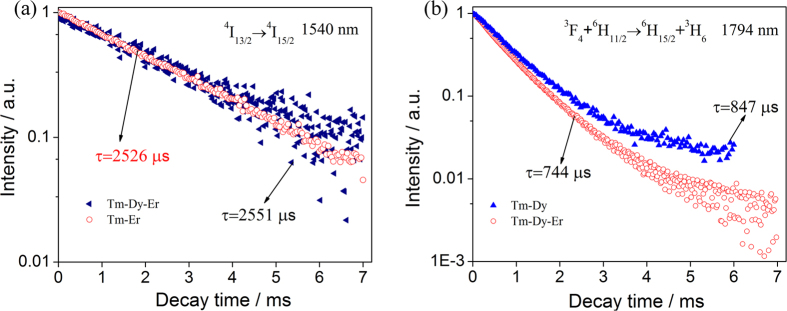
Decay curves of (a) the 1540 nm emission (Er3+: 4I13/2 → 4I15/2) in Tm3+-Er3+ co-doped and Tm3+-Dy3+-Er3+ triply-doped samples, and (b) the 1794 nm emission (Dy3+: 6H11/2 → 6H15/2 and Tm3+: 3F4 → 3H6) in Tm3+-Dy3+ co-doped and Tm3+-Dy3+-Er3+ triply-doped 65GeS2–25In2S3–10CsI glasses.